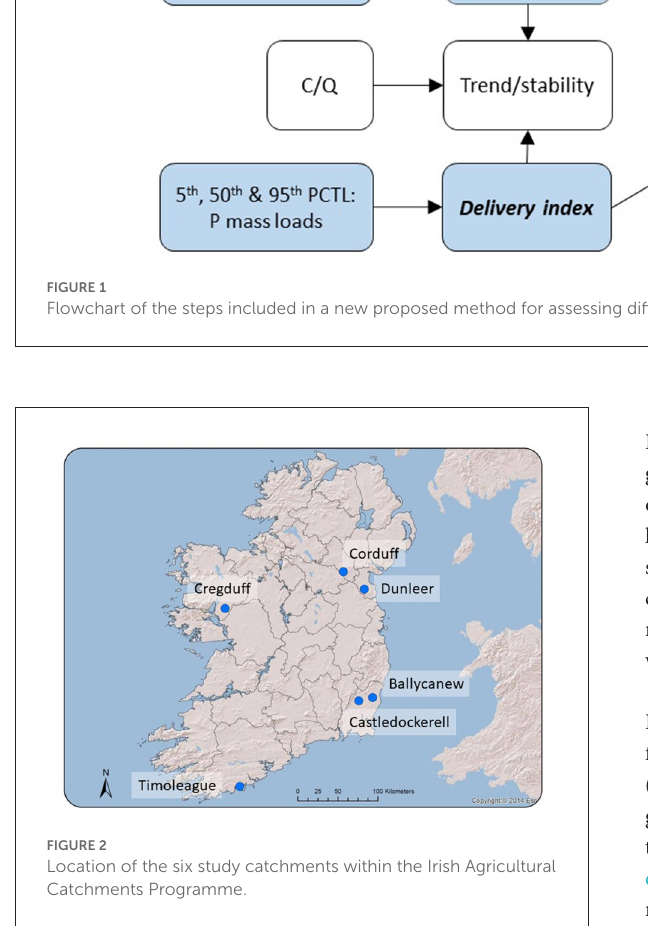
valley bottoms. The hydrological pathways are mostly quick and